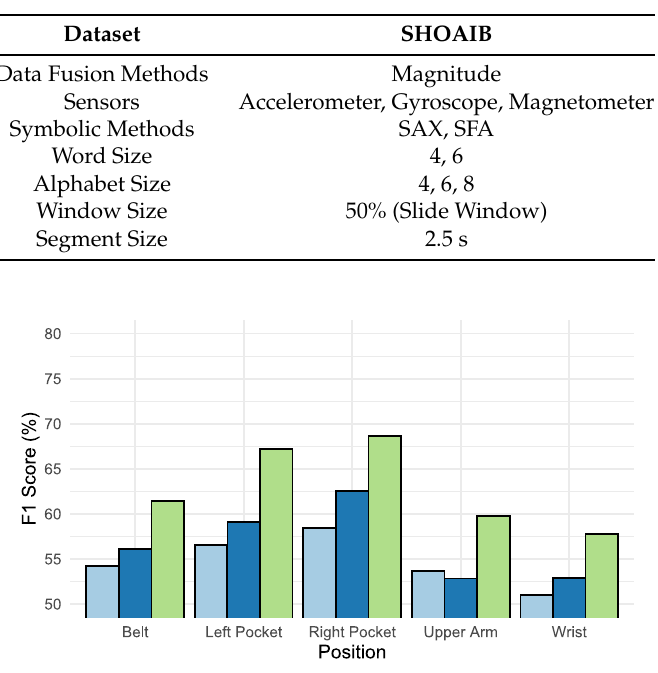
Table 7. Parameter variation of word size and alphabet size.